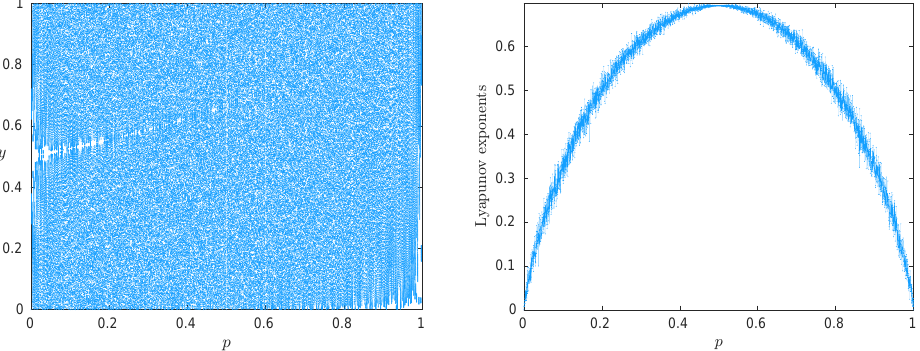
Figure 3. The bifurcation diagram of the skew-tent map ( left ), and its Lyapunov exponents ( right